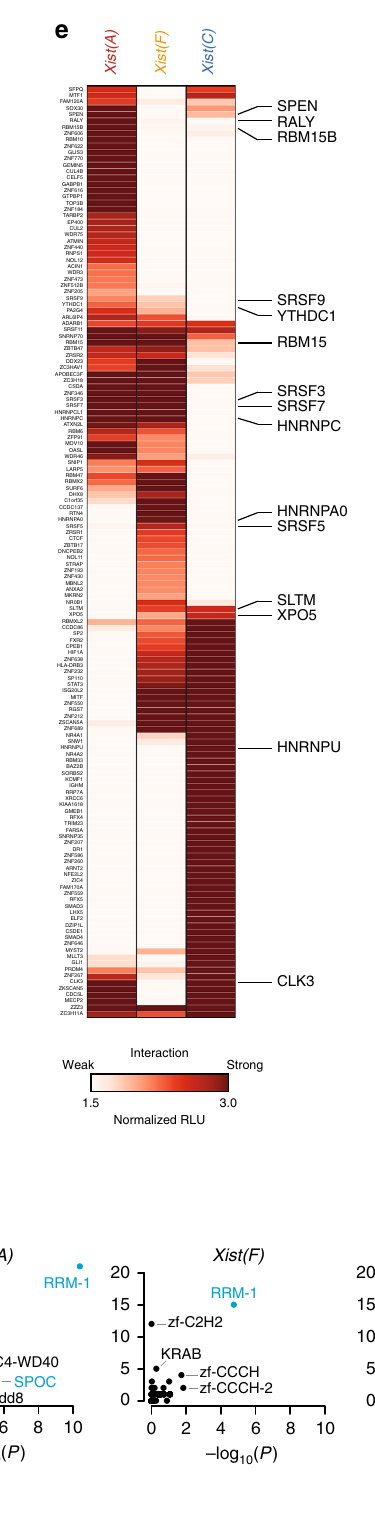
Sorted Xist ( A ) interactors